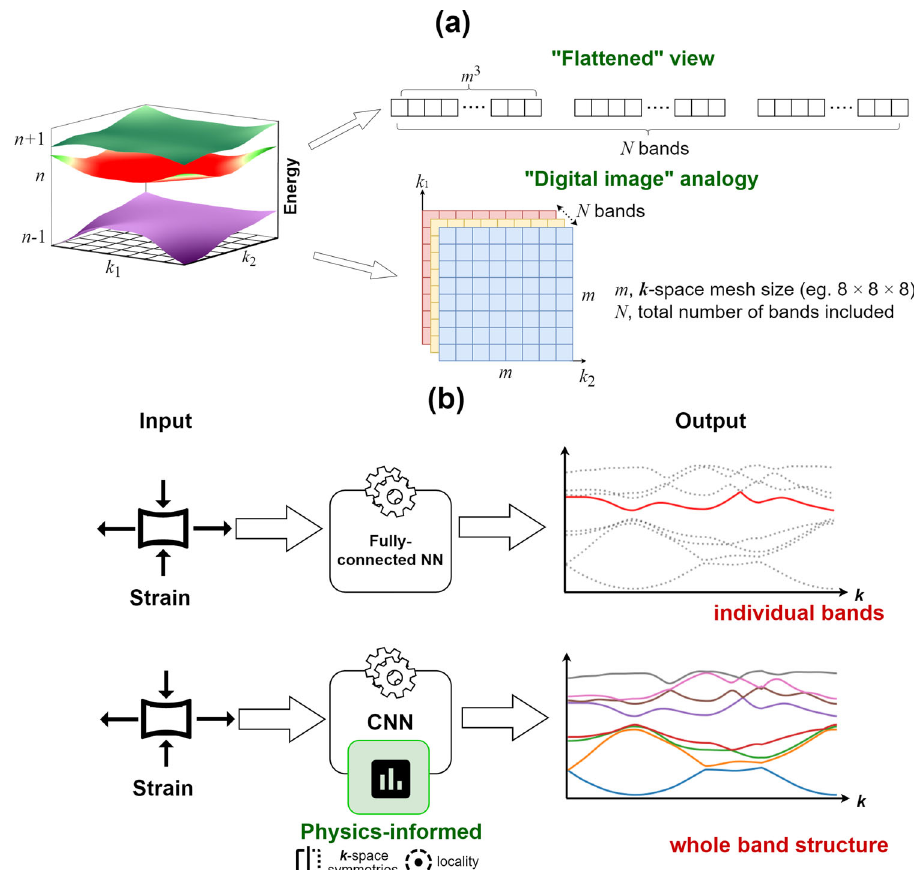
Fig. 1 Two different views of the band structure. a Different representation of a band structure. In the “ fl attened ” view, a band structure is represented as N stacked fl attened arrays (vectors) and processed like independent values. Each array is m 3 in length. In the “ digital image ” analogy, the band structure is envisioned as N different 3D images stacked together, each of which has a “ voxel ” dimension of m × m × m . The eigenvalues on an energy band can then be thought of as the “ color-scale ” of the voxels. b Comparison of the two different approaches to ML. We predict the eigenvalues for each energy band separately by utilizing the “ fl attened ” band structure representation to obtain the entire band